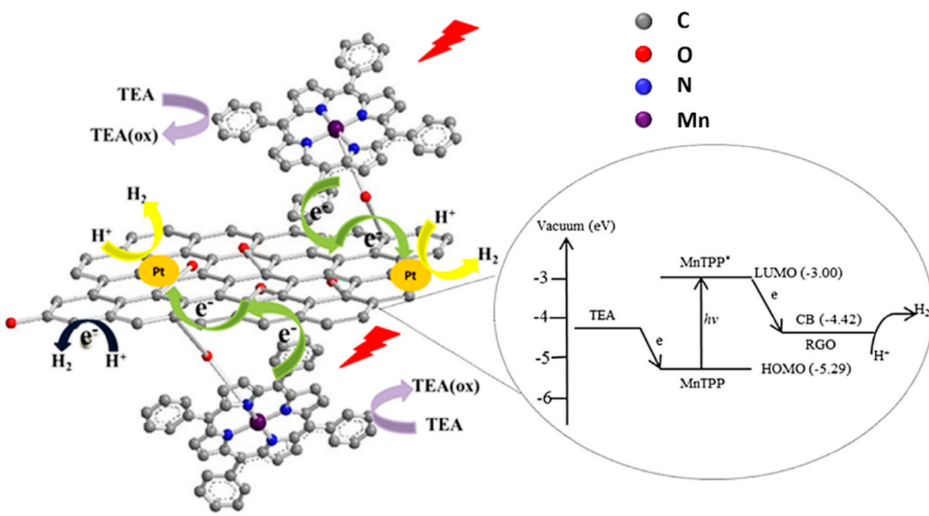
Figure 20. Diagram of the proposed photocatalytic mechanism for GO-MnTPP/Pt. Reproduced from [127] with the permission of World